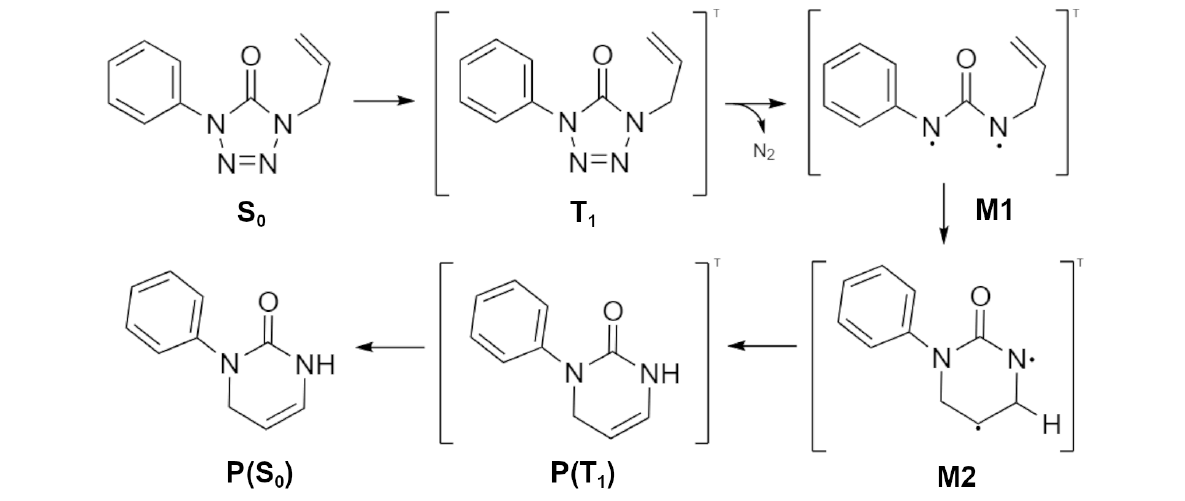
Figure 1. Postulated mechanism for the photodegradation of 1-phenyl-4-allyl-tetrazol-5-one (ATZ) in methanol